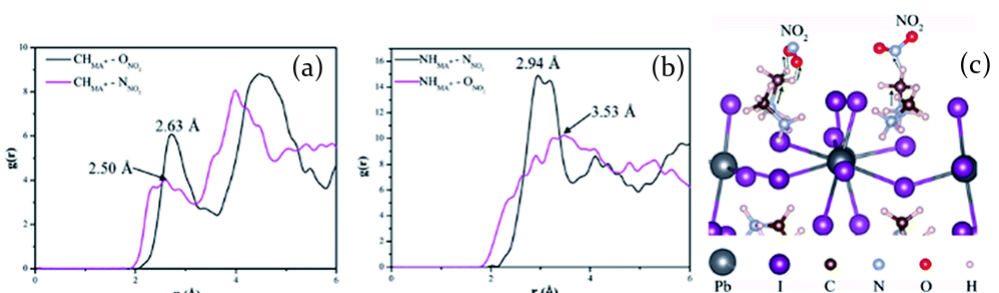
Figure 12. Radial distribution functions (RDF) of adsorbed NO 2 molecules on the (110) face of MAPbI 3 , including both hydrogen bond interactions with ( a ) − CH 3 (peaks 2.50 Å and 2.63 Å) and ( b ) − NH 3 (peaks at 2.94 Å and 3.53 Å). ( c ) Schematic illustration of the electron transfer process from perovskite to the NO 2 molecules via the hydrogen bond channel. Adapted with permission from [87] under the terms of the Creative Commons Attribution 3.0 Unported license. Copyright © 2018, Royal Society of